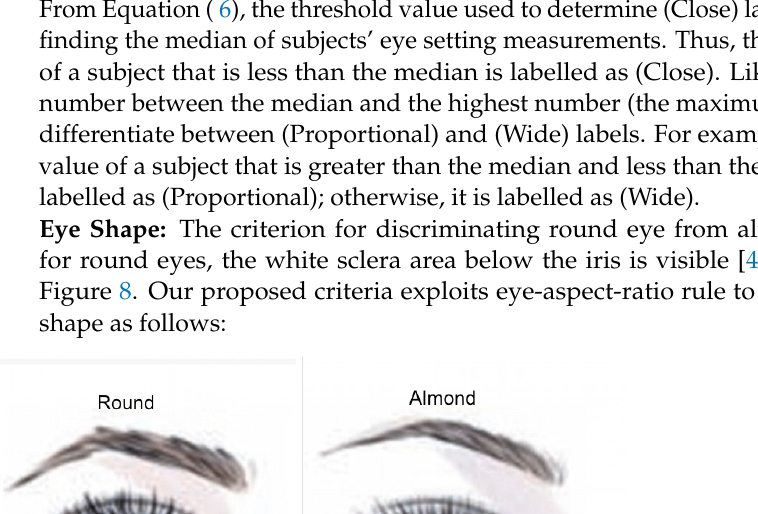
Figure 8. Round vs. almond